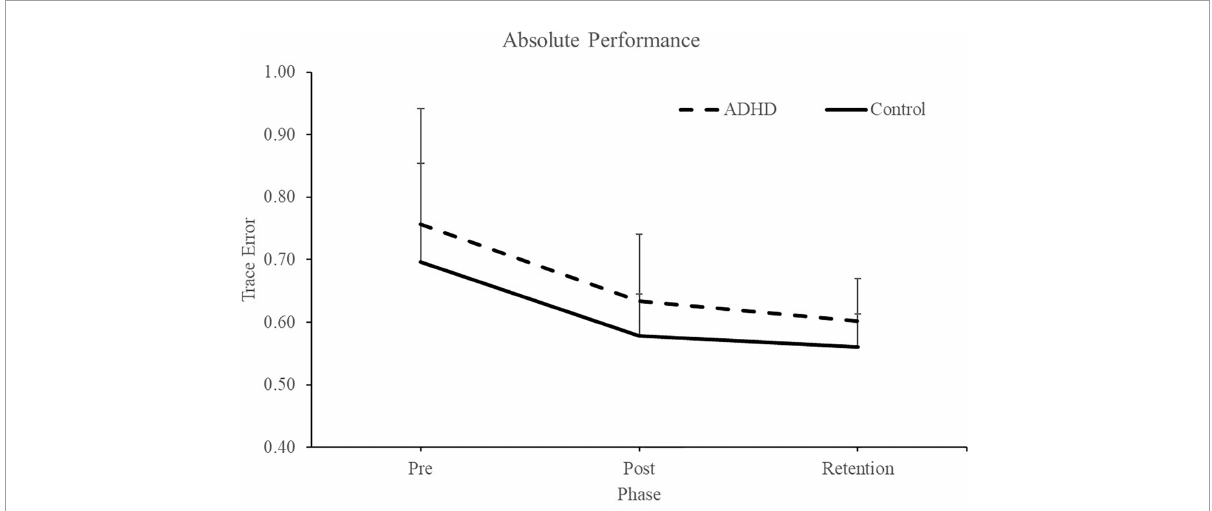
FIGURE4 Depiction of the custom force-matching task (FMT) program on LABVIEW as participants view it. The yellow line indicates the participants force output on the transducer. The white line is the intended trace, while red lines reflect boundary guides. The y -axis of the program is the amplitude of the trace, which is calibrated as a percent (%) of each participants MVC, and vary from 2 to 12% MVC. The x -axis is the trace as it progresses through time from 0 to 20s.